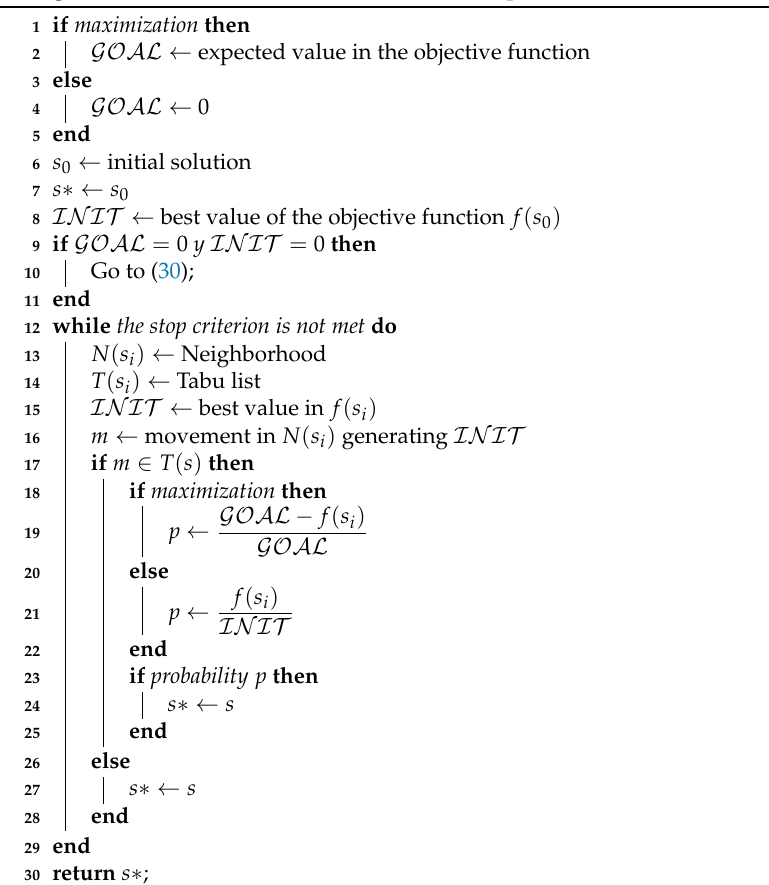
Algorithm 1: Tabu Search with Probabilistic Aspiration